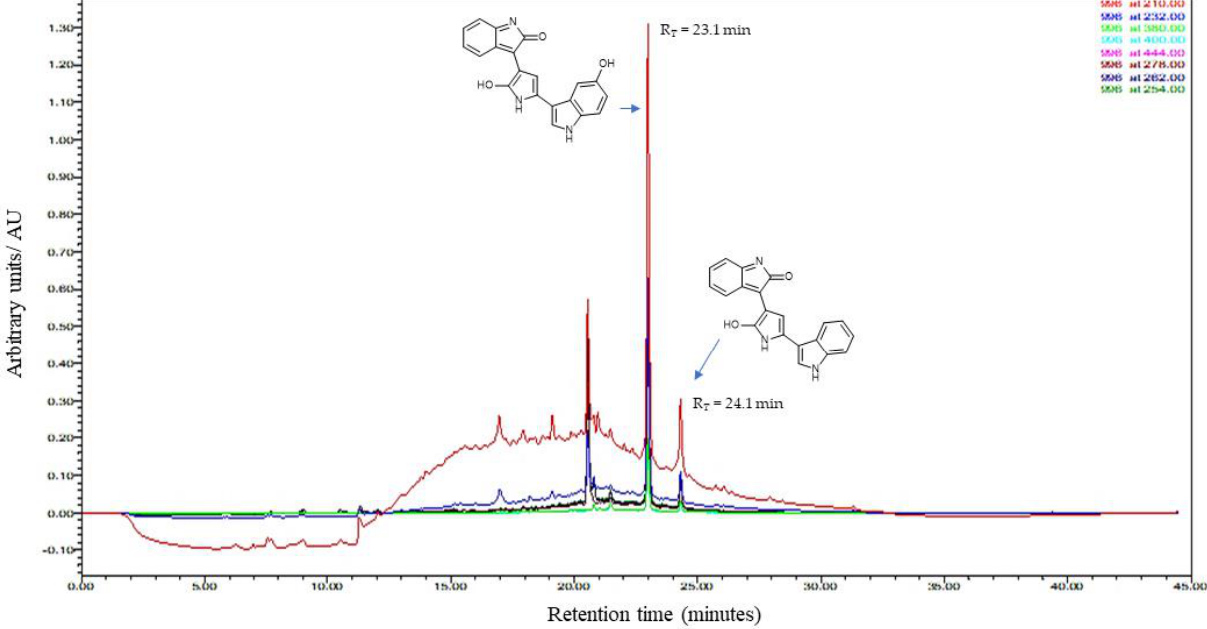
Figure 2. HPLC chromatogram of fraction C containing violacein (R T 23.1 min) and deoxyviolacein (R T 24.1 min) in J. lividum . Note: the HPLC chromatograms of violacein and deoxyviolacein in J. lividum, J. agaricidamnosum , and mixed fractions showed a similar pattern.